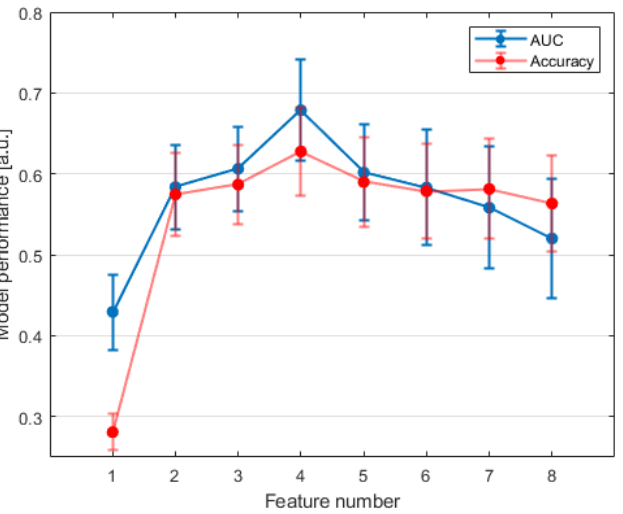
Figure 4. Model performance as a function of the increasing number of features.